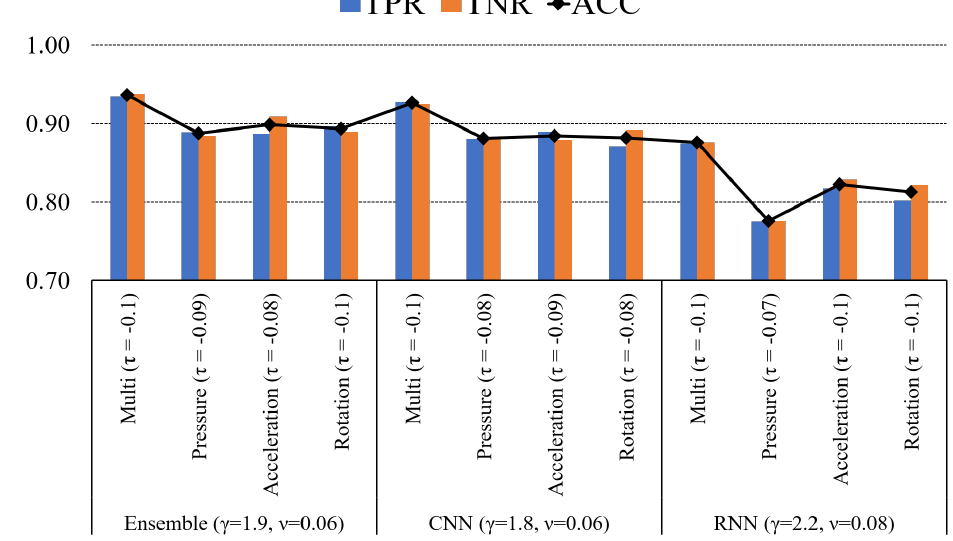
Figure 9. Performance comparison between sensing modalities. Table 1. Performance of the network models using multi-modal and uni-modal sensing. The blue color denotes the best accuracy of each network